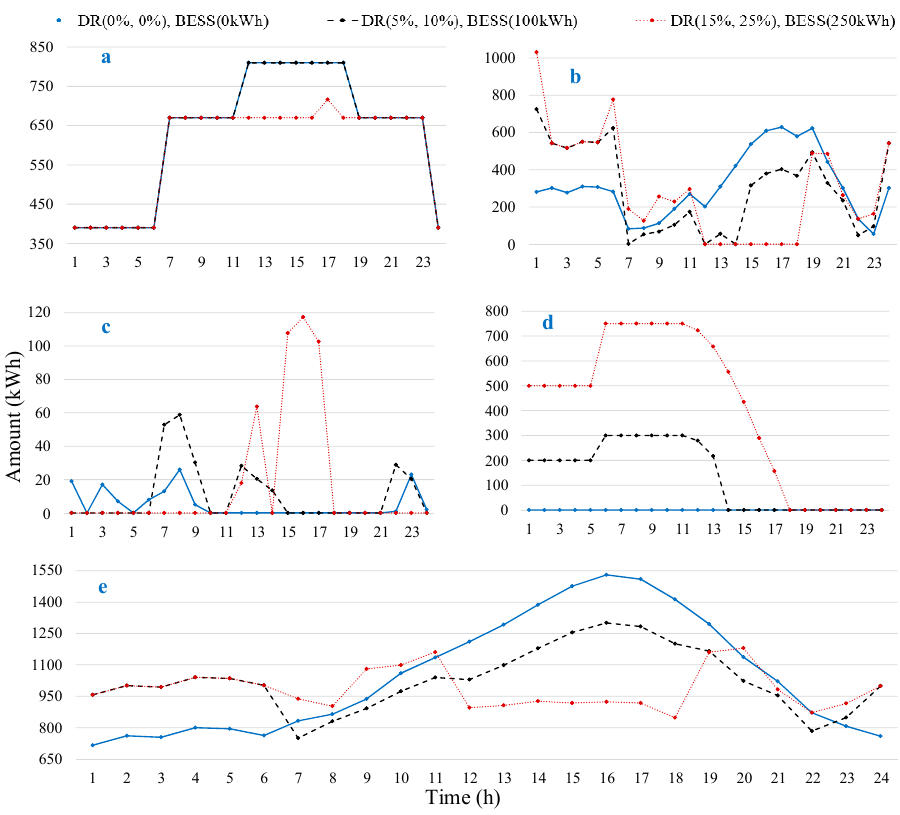
Figure 8. ( a ) Generation of CDGs; ( b ) external power trading; ( c ) internal power transfer; ( d ) BESS SOC; ( e ) load profile of microgrid network.